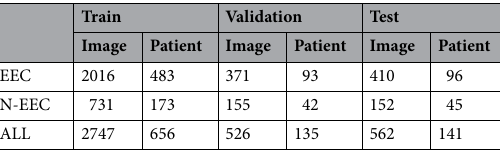
Table 1. Statistical table of esophageal endoscopy image data set used in this